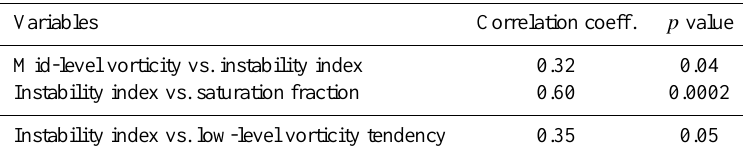
Variables Correlation coeff. p